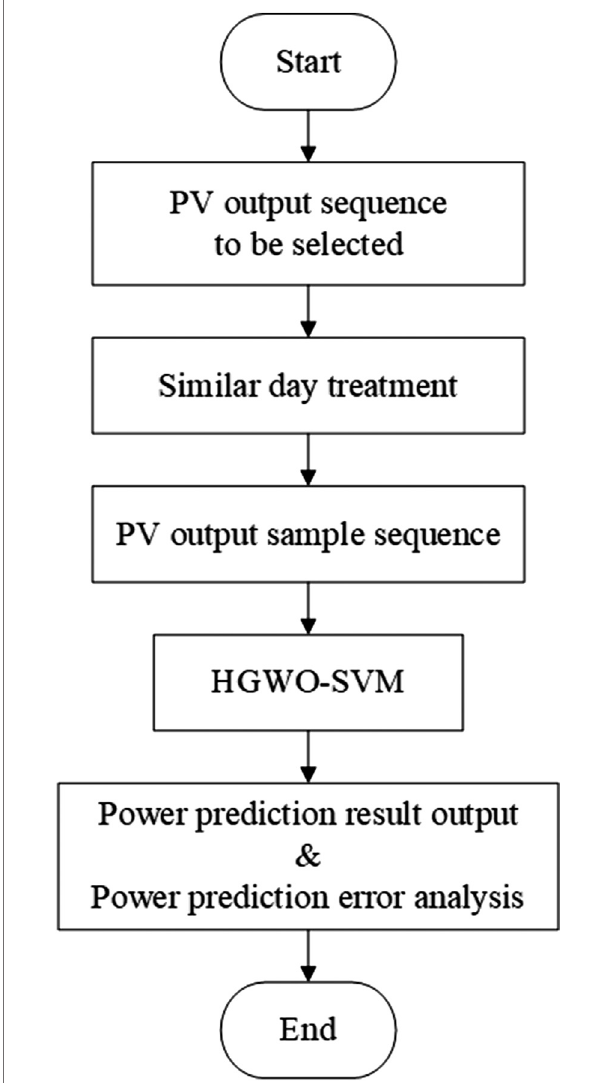
FIGURE 3 | HGWO-SVM prediction model.